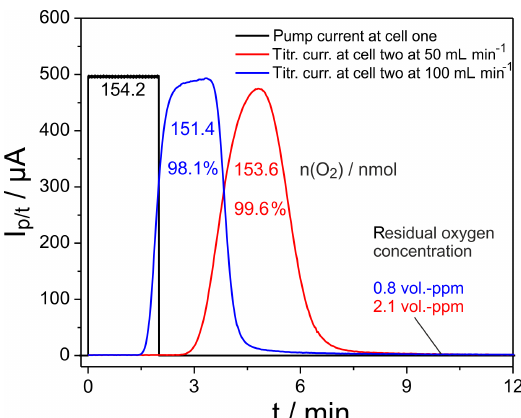
Figure 4. Amount of oxygen, slipped through cell two during titration as a measure for the electrode kinetics, depending on the amount of introduced oxygen at different flow rates; cell tempera- tures 750 ◦ C.